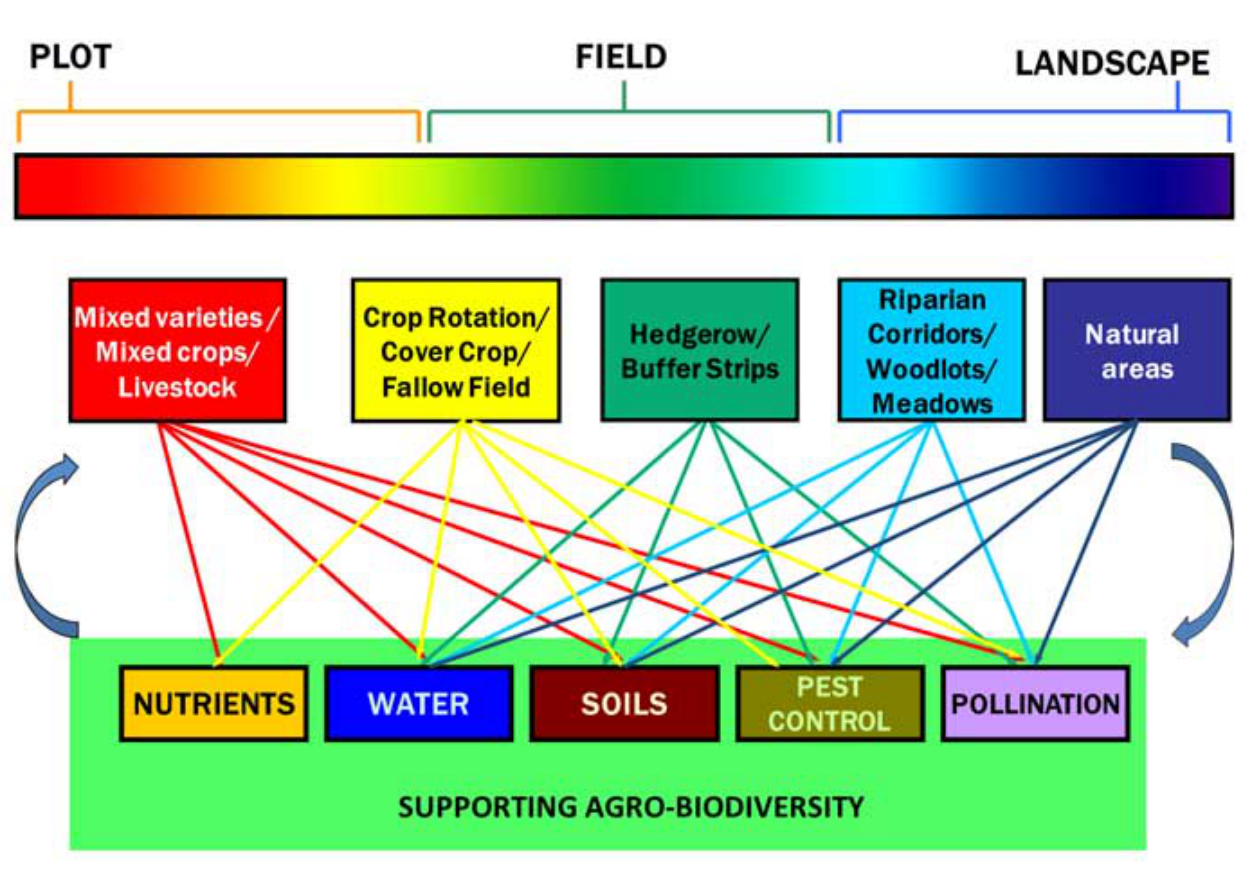
Fig. 1 . Conceptual model of a Diversified Farming